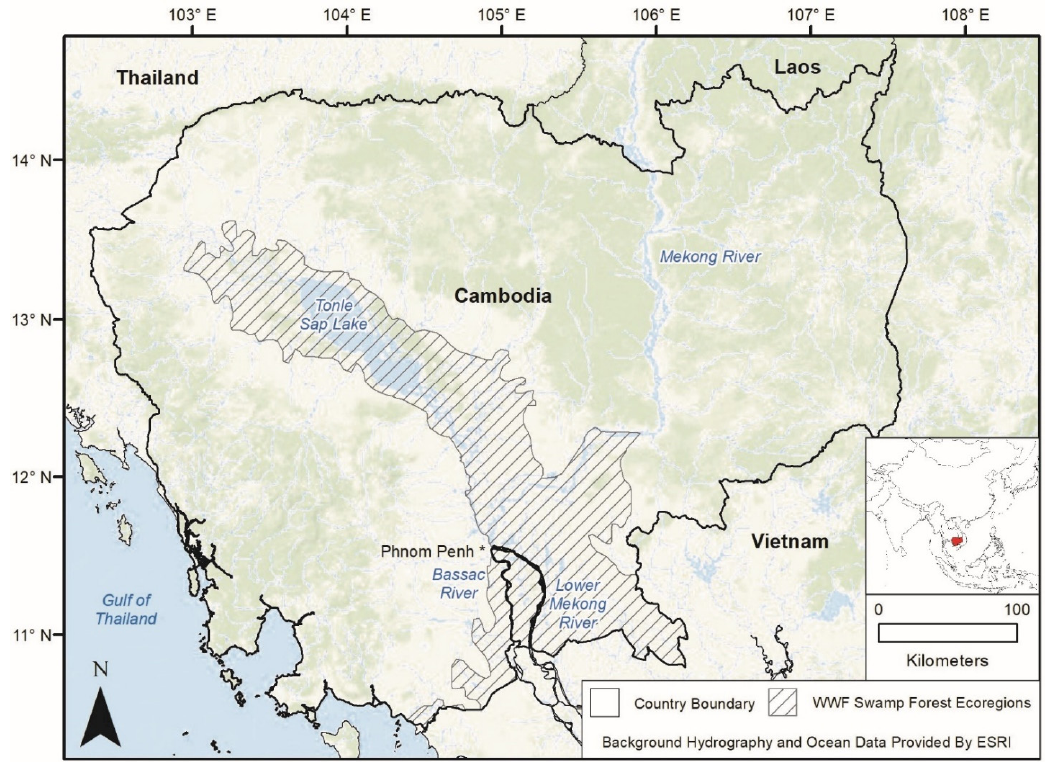
Figure 1. The study area encompasses the country of Cambodia. The lower Mekong River and a large floodplain surrounding Tonle Sap Lake have highly seasonal inundation dynamics.